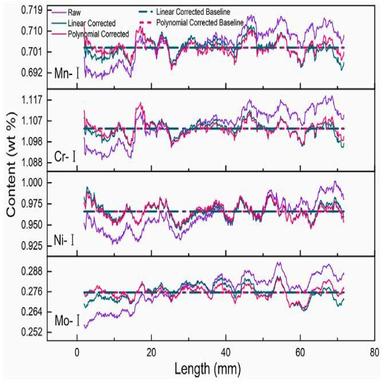
The raw and corrected line and corrected baseline for Mn, Cr, Ni, Mo of A11.